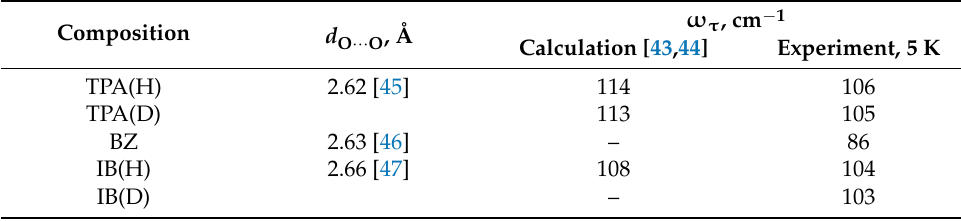
Table 1. The length of the hydrogen bond and the frequency of translational vibrations ω τ in the studied